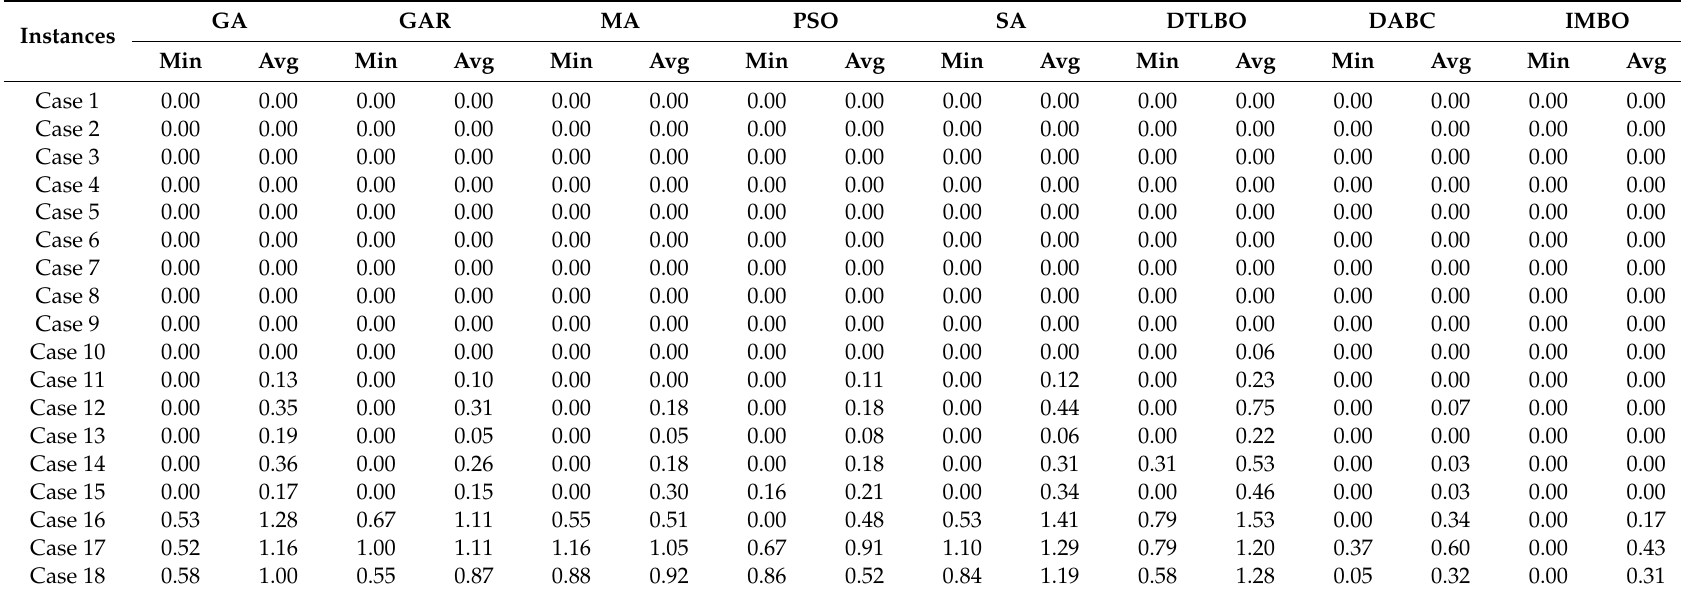
Table 12. Comparison results for minimum RPD and average RPD when ρ =